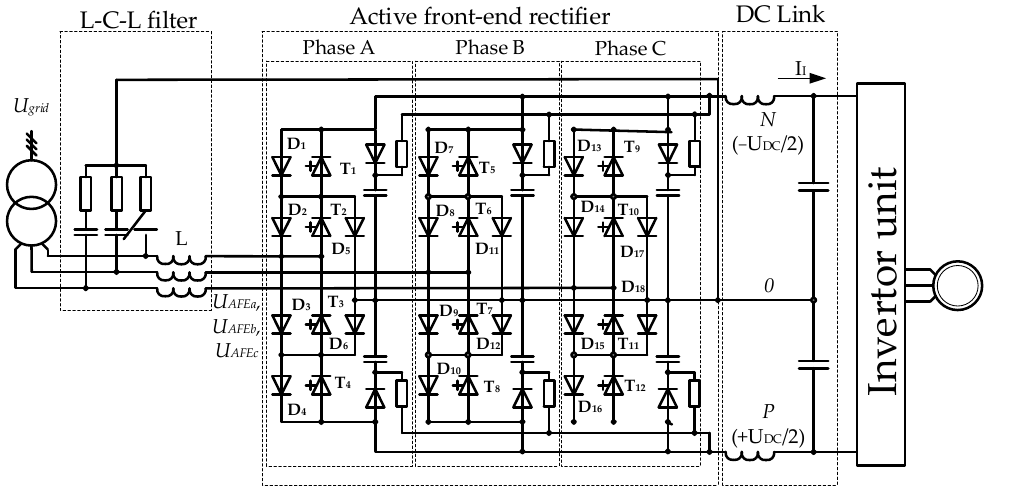
Figure 1. The simplified FC-AFE circuit.